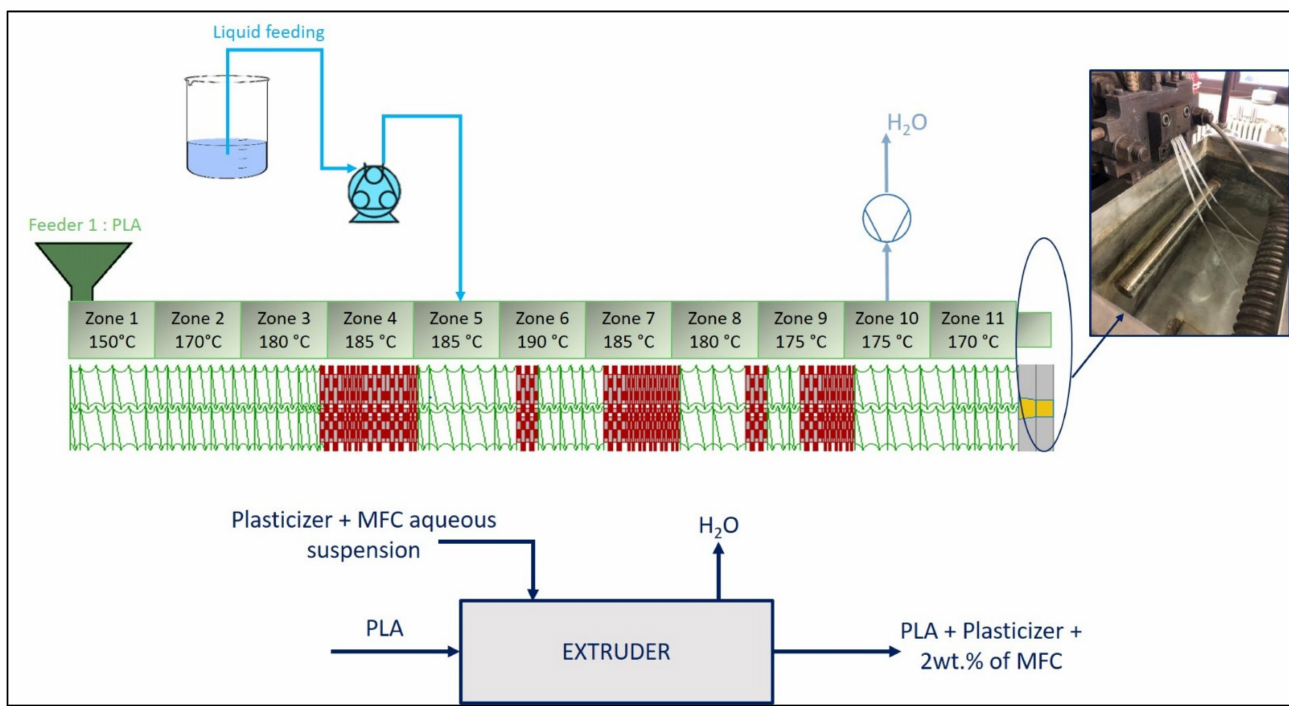
Figure 1. Schematization of the inlet and outlet flows in a semi-industrial twin-screw extruder coupled with the temperature profiles and the screws